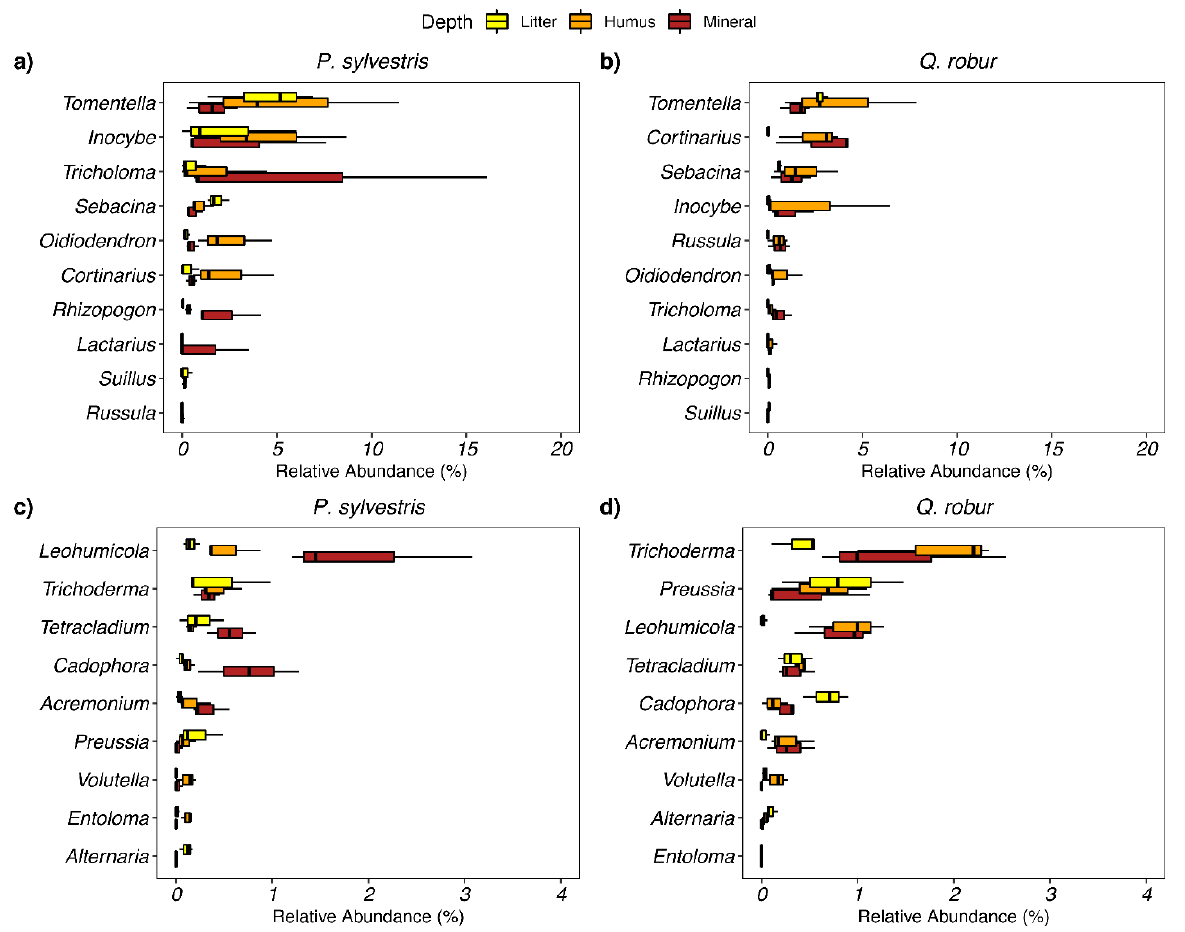
Figure 2. Boxplots of relative read abundance (%) of a – b) mycorrhizal and c-d) saprotrophic fungi for the most abundant species in pine and oak soil layers (litter-L, humus-H and